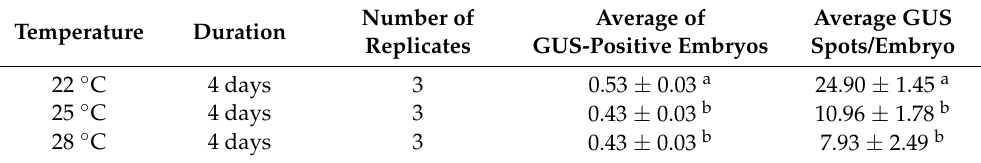
Table 2. The effect of cocultivation temperature on GUS expression in SEs. Temperature Duration